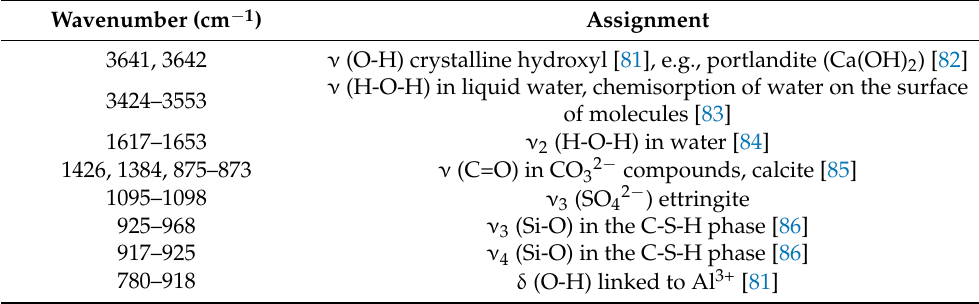
Figure 7 . The IR analysis of the hydration process of ( a ) ROR, ( b ) ENO3/10, ( c ) ENO7/10, ( d ) BOR/10 . Table 11. Assignments of the major absorption bands of hydrated mixtures.